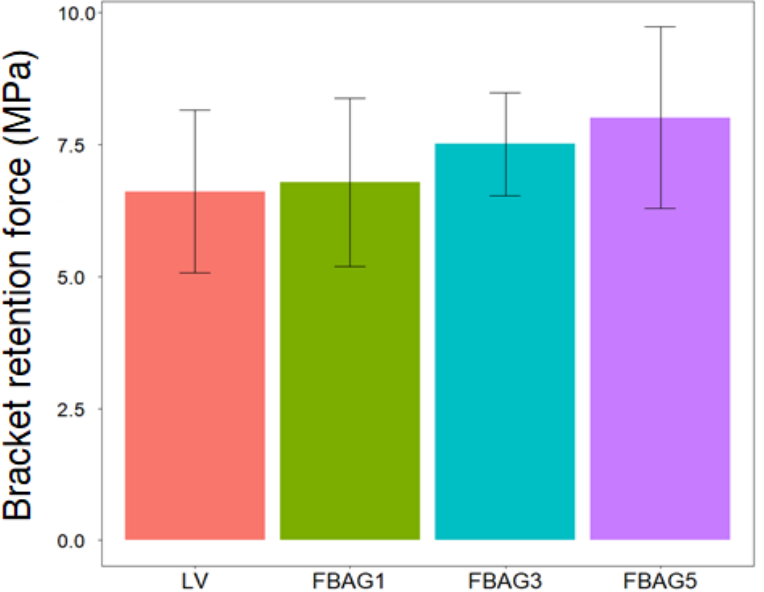
Figure 5. Bracket retention test of LV and FBAG containing group. There was no difference between the groups by one-way ANOVA (p > 0.01). Error bars represent ± standard error (n = 5).